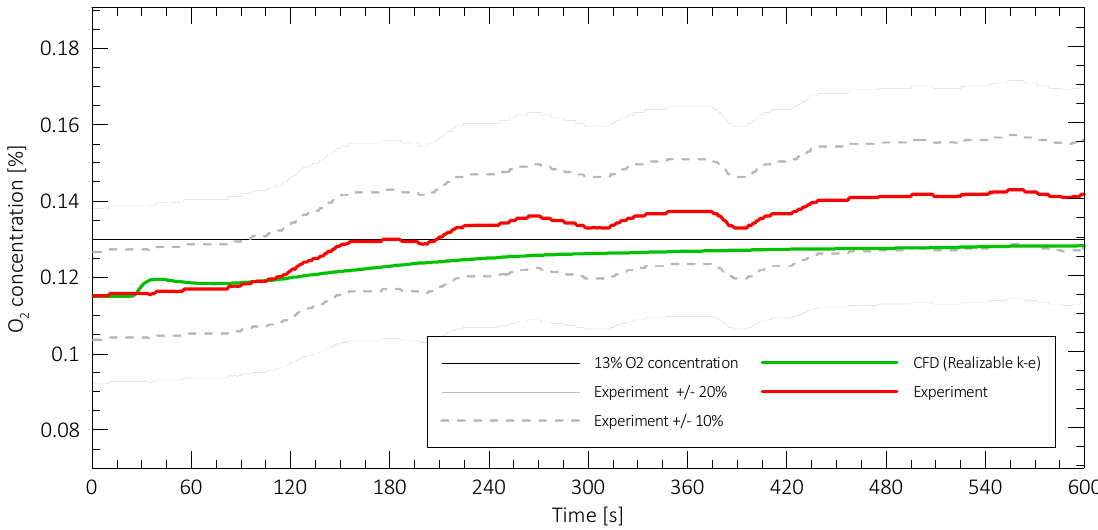
Figure 18. Changes in oxygen concentration (v/v) on the probe No. 1, indicating the end of the retention time during experimental tests and CFD simulations, fire-extinguishing gas Ar 7.5% v/v and N 2 92.5% v/v.